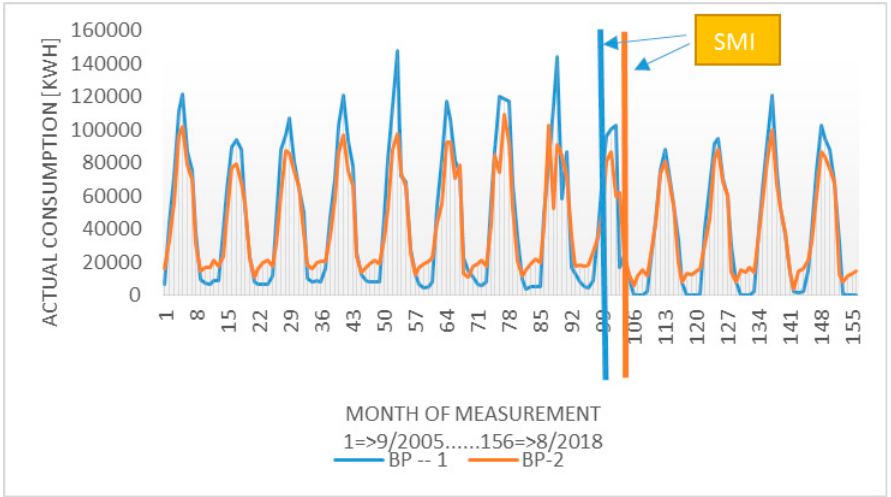
Figure 3. Comparison of actual consumption for BP1 and BP2 customers.